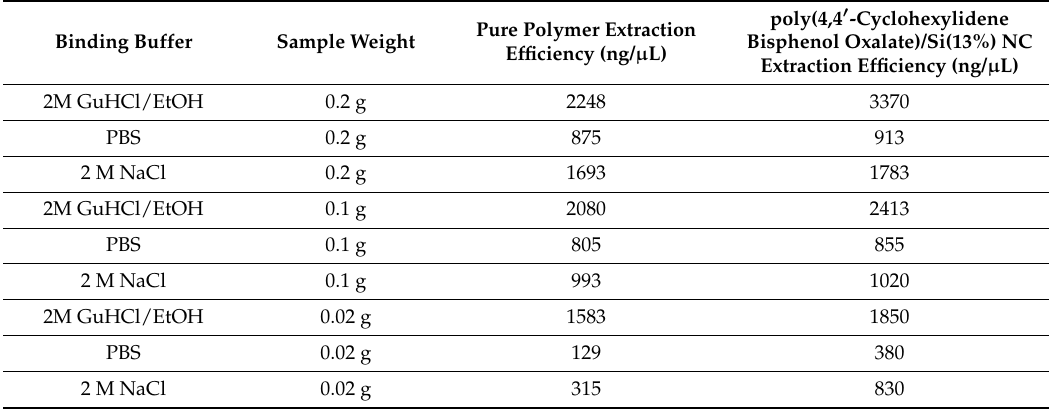
Table 7. Comparison of the extraction efficiencies of pure polymer, poly(4,4 (cid:48) -cyclohexylidene bisphenol oxalate), with that of poly(4,4 (cid:48) -cyclohexylidene bisphenol oxalate)/Si(13%)